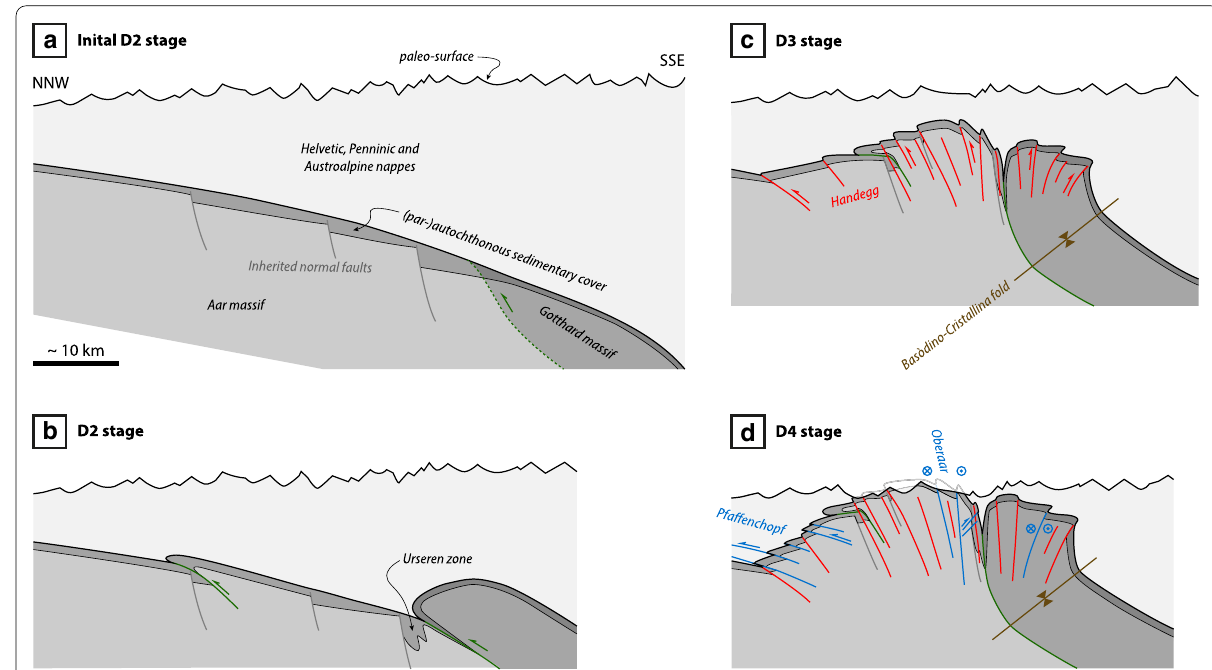
Fig. 2 Simplified illustration of the Alpine tectonic evolution of the Aar and Gotthard massif. The area labeled ‘Helvetic, Penninic and Austroalpine nappes’ also includes flysch and Molasse units. Colored terms indicate deformation phases described in the text. Modified from Nibourel et al. (2021), Herwegh et al. (2017) and Ricchi et al. (2019). Interpretations based on the present study have been supplemented to the Gotthard